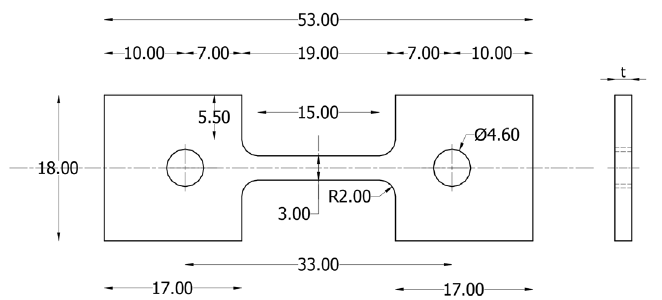
Figure 1. Tensile specimens (unit: mm).